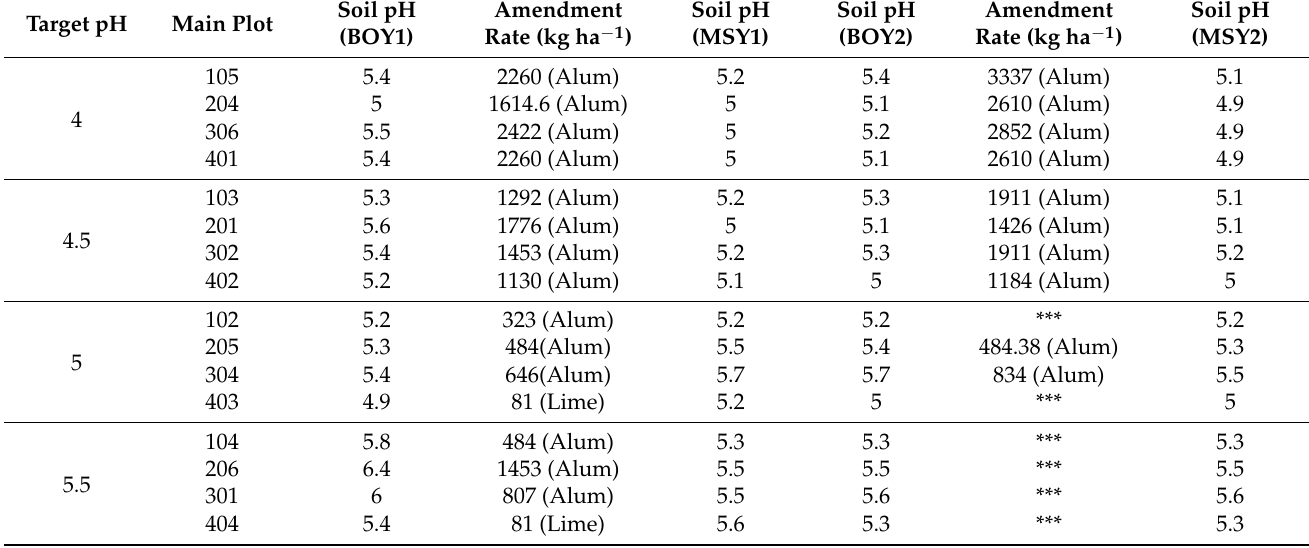
Table 5. Continuous monitoring for 2 winter wheat cropping seasons regarding soil pH, target soil pH, and aluminum sulfate (Alum) and calcium hydroxide (Lime) amendment rates for each main plot at